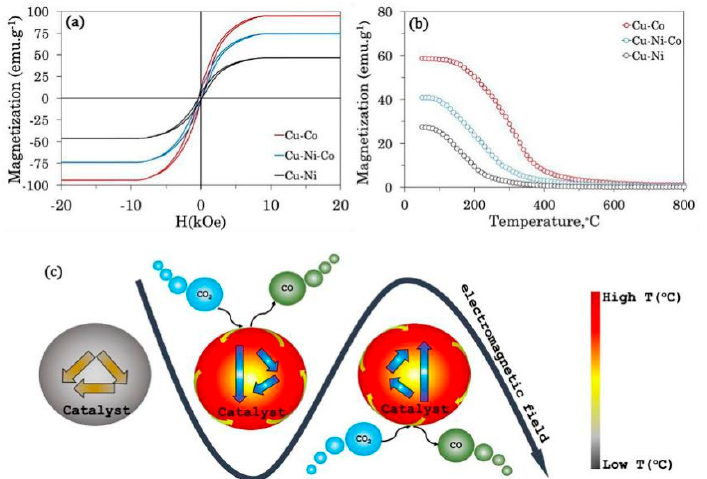
Figure 13. Induction heating of magnetic catalyst for hydrogen production ( a ) hysteresis; ( b ) thermomagnetic curve; ( c ) induction heating mechanism of catalyst [80].